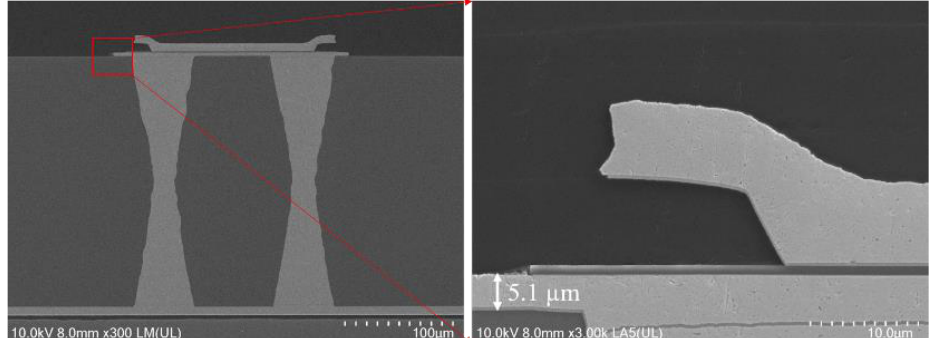
Figure 15. The cross sectional SEM view of TGVs with Cu full filling and RDL layer.